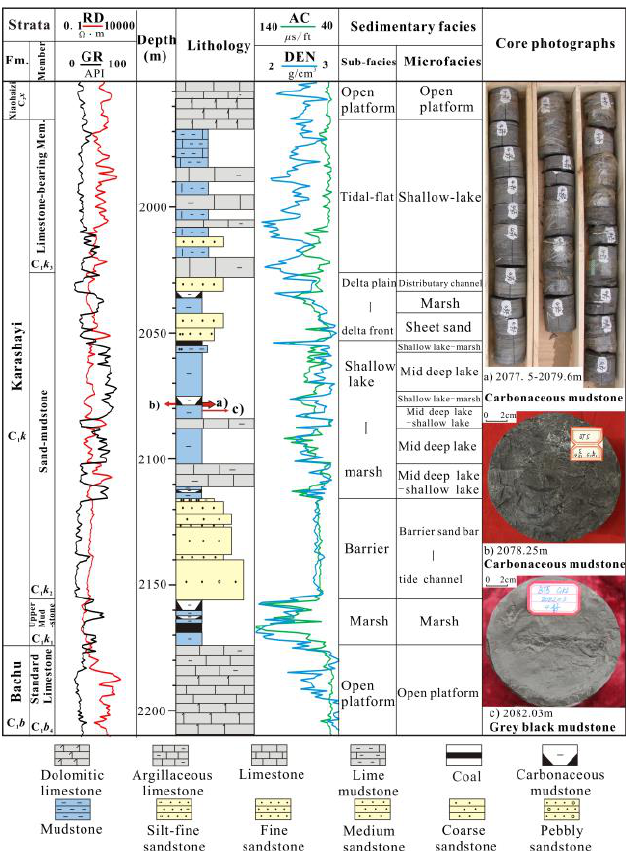
Figure 2. A comprehensive stratigraphic profile of the Carboniferous Karashayi Formation of well